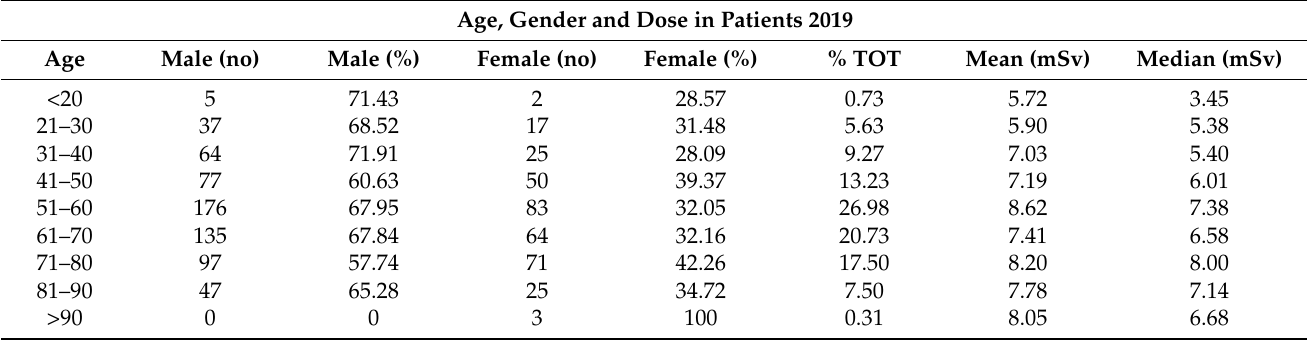
Table 2. Dose in no COVID patients by age and gender.